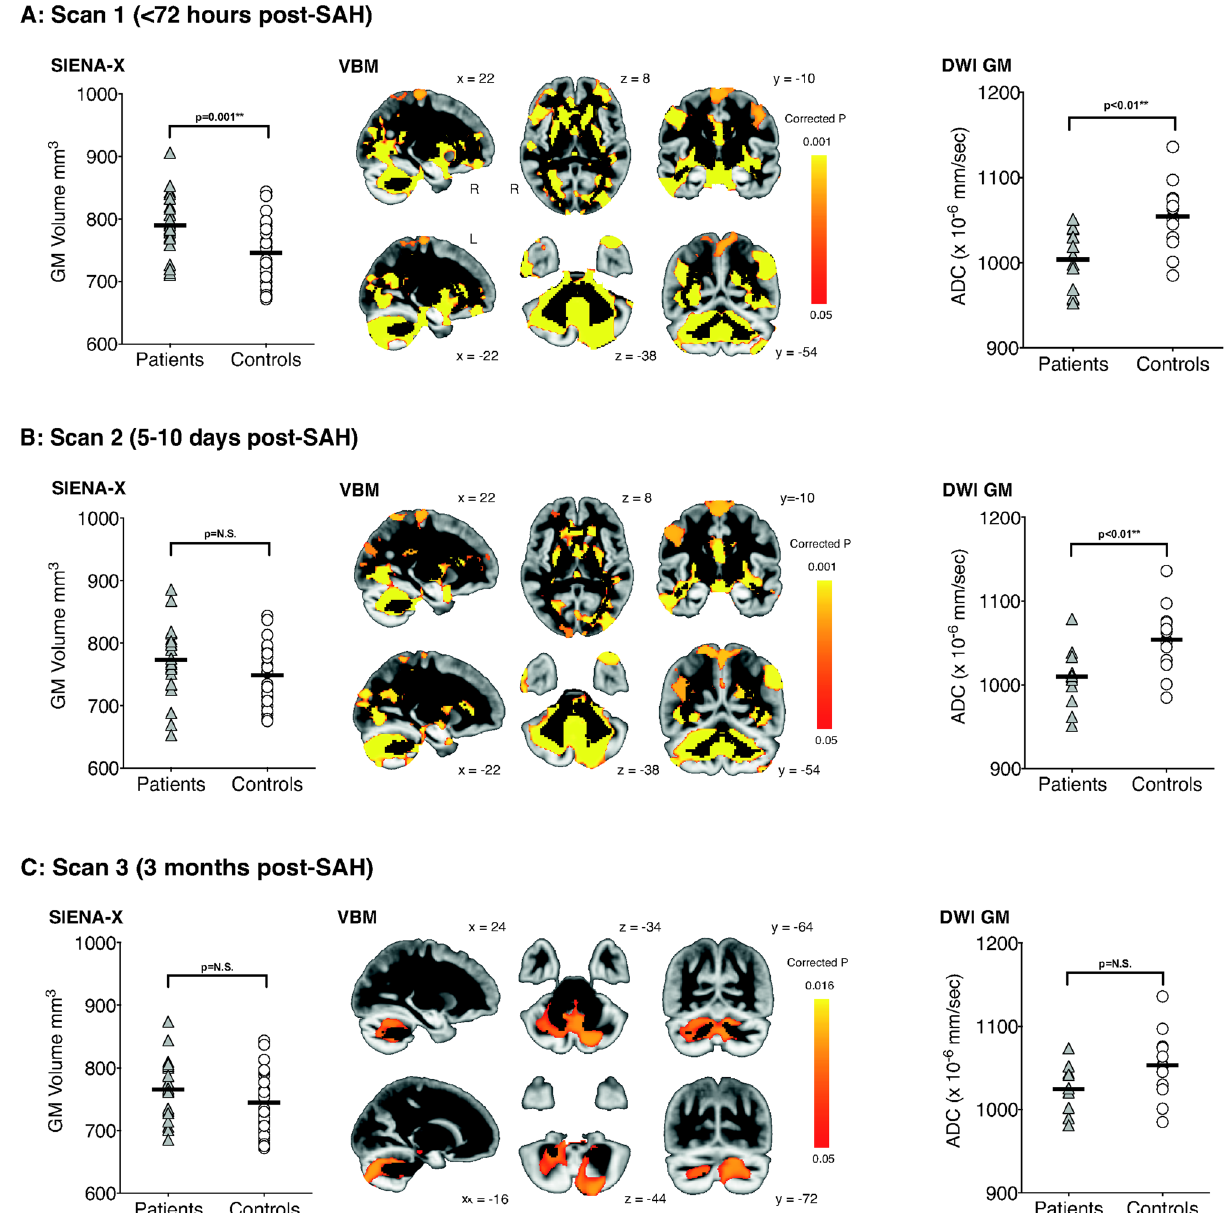
Figure 2. Higher GM volume (global: SIENA-X, local: VBM) and lower GM DWI between SAH patients and healthy controls in acute phase subside at 3 months post-SAH, except in the cerebellum. Results are given for each timepoint ( A acute phase, < 72 h post-SAH; B 5–10 days post-SAH; and C 3 months post-SAH). Left, plots showing results from the SIENA-X analyses looking at mean whole-brain GM volume. Middle, results from the voxel-by-voxel VBM analysis showing in red-yellow the GM areas where patients have apparent higher volume (p < 0.05-TFCE-corrected for multiple comparisons, overlaid onto the average of all 54 GM volume images). Right, plots showing the mean ADC values in a whole-brain GM mask. L is